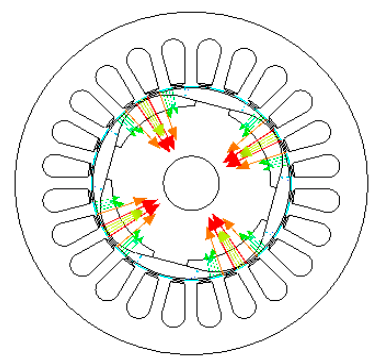
Figure 3. Radial Force distribution.